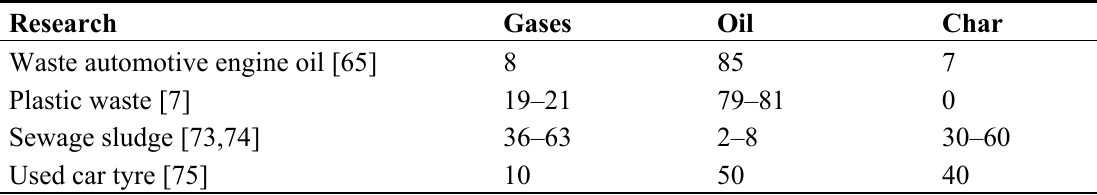
Table 2. Product yield (wt%) from microwave pyrolysis of waste materials for energy